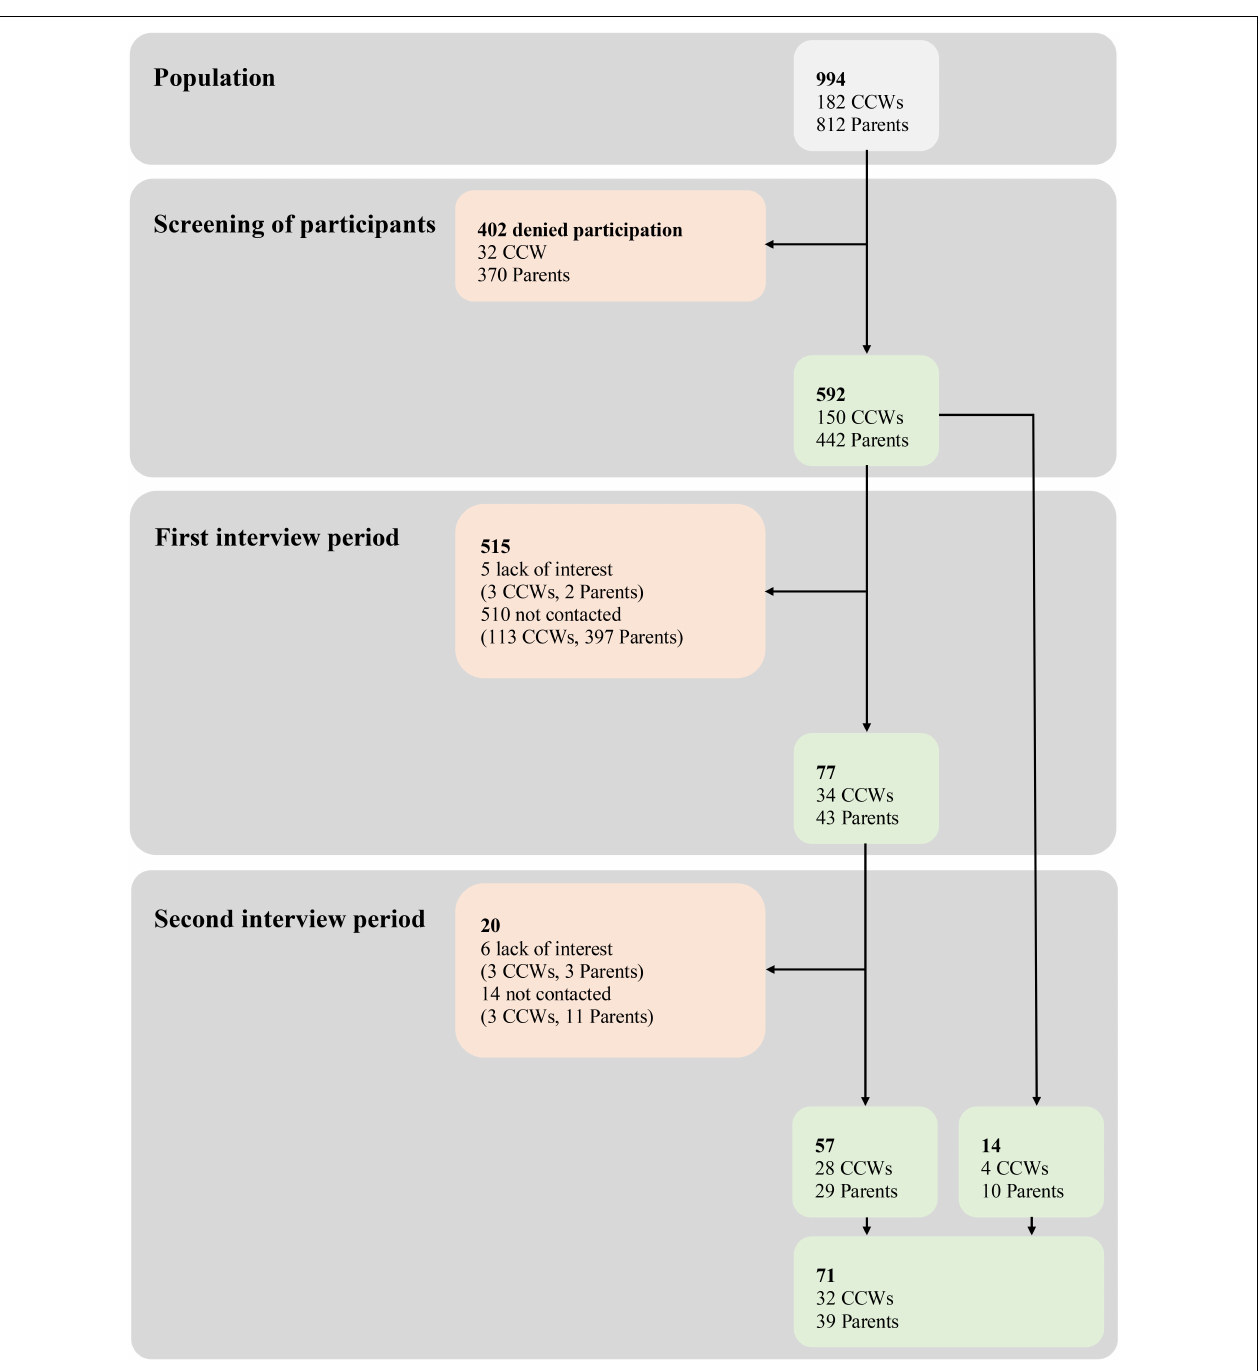
FIGURE 1 | Flow of participants throughout the study with reasons for inclusion/exclusion. Light gray, parents and CCWs belonging to the nine DCCs involved in Wü-KiTa-CoV and screened for interest in being interviewed; light green, parents and CCWs included; light red, parents and CCWs excluded (with reasons).